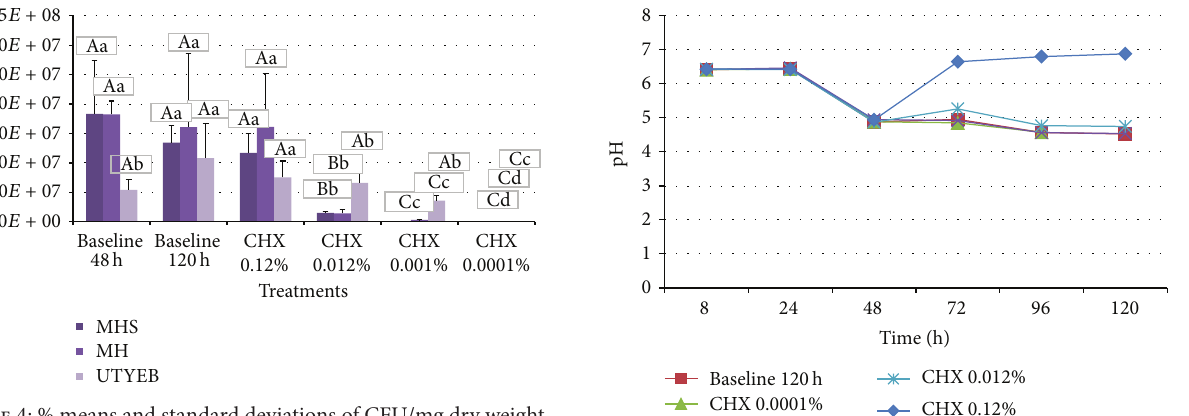
Figure 4: % means and standard deviations of CFU/mg dry weight in the biofilms grown according to the treatments. Capital letters indicate statistical differences between culture media, and lowercase letters indicate statistical differences according to the treatments using each culture medium, by Tukey test ( 𝑝 < 0.05 ).